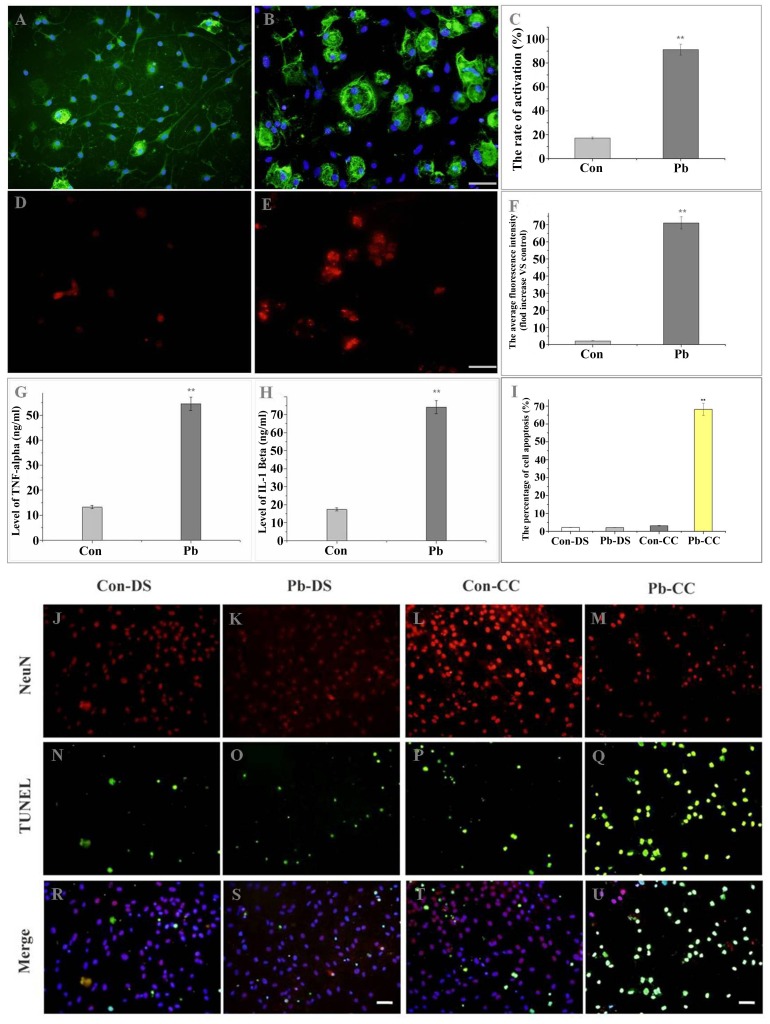
Pb activated microglia, enhanced TNF-α and IL-1β secretes, iNOS expression, and induces hippocampal neuronal injury.Purified microglia cells were seeded in 12-well culture plates. Cells were treated with vehicle (control) (A) or Pb (50 µmol) (B) for the indicated times. Microglia activation was detected by immunocytochemistry (OX42). (A) control; (B) 50 µmol Pb for 48 h. (C) The results were quantified. Results (A and B) are expressed as the mean ± S.D. of average activated cell rate in random fields (n = 20). **P<0.001 compared with control groups. Scale bar indicates 50 µm. iNOS was detected by immunofluorescence staining. Activation of iNOS was evaluated by measure the average fluorescence of iNOS-immunoreactive cells (D, E). (F) The results were quantified and are expressed as the mean ± S.D. of average fluorescence of iNOS-immunoreactive cells in random fields (n = 20). ** P<0.001 compared with control groups. Scale bar indicates 50 µm. TNF-α (G) and IL-1β (H) were determined by ELISA. Purified microglia were cultured with vehicle (control) or Pb (50 µmol) for 48 h for the TNF-α and IL-1β assay, respectively. ** P<0.001 compared with control groups. The purified microglia were co-cultured with hippocampal neurons for 48 h after culturing with vehicle (control) (L, P, T) or Pb (50 µmol) (M, Q, U) for 48 h. Apoptosis of hippocampal neurons was detected with in situ TUNEL (green fluorescence). Degeneration of hippocampal neurons was evaluated by counting the number of apoptotic neurons. As compared with the co-culture method, hippocampal neurons were also treated with vehicle (control) (J, N, R) or Pb (50 µmol) (K, O, S) directly for 48 h. (I) The results were quantified and are expressed as the mean ± SD of apoptotic neurons percentage in random fields (n = 20). ** P<0.001 compared with control groups. Scale bar indicates 50 µm. CC in figure means co-culture method; DS in figure means direct stimulation method.